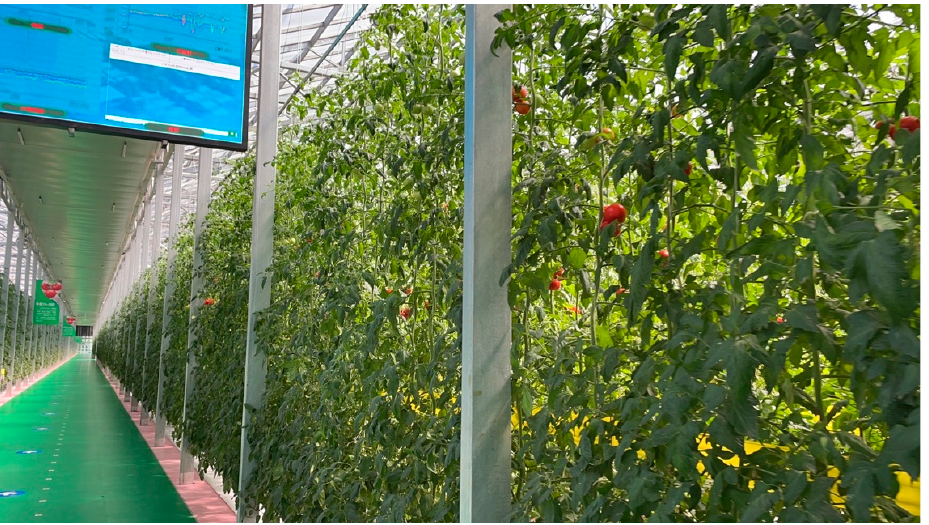
Figure 1. National Vegetable Quality Standard Center (Shouguang, Shandong) Science and Technology Demonstration and Promotion Base.